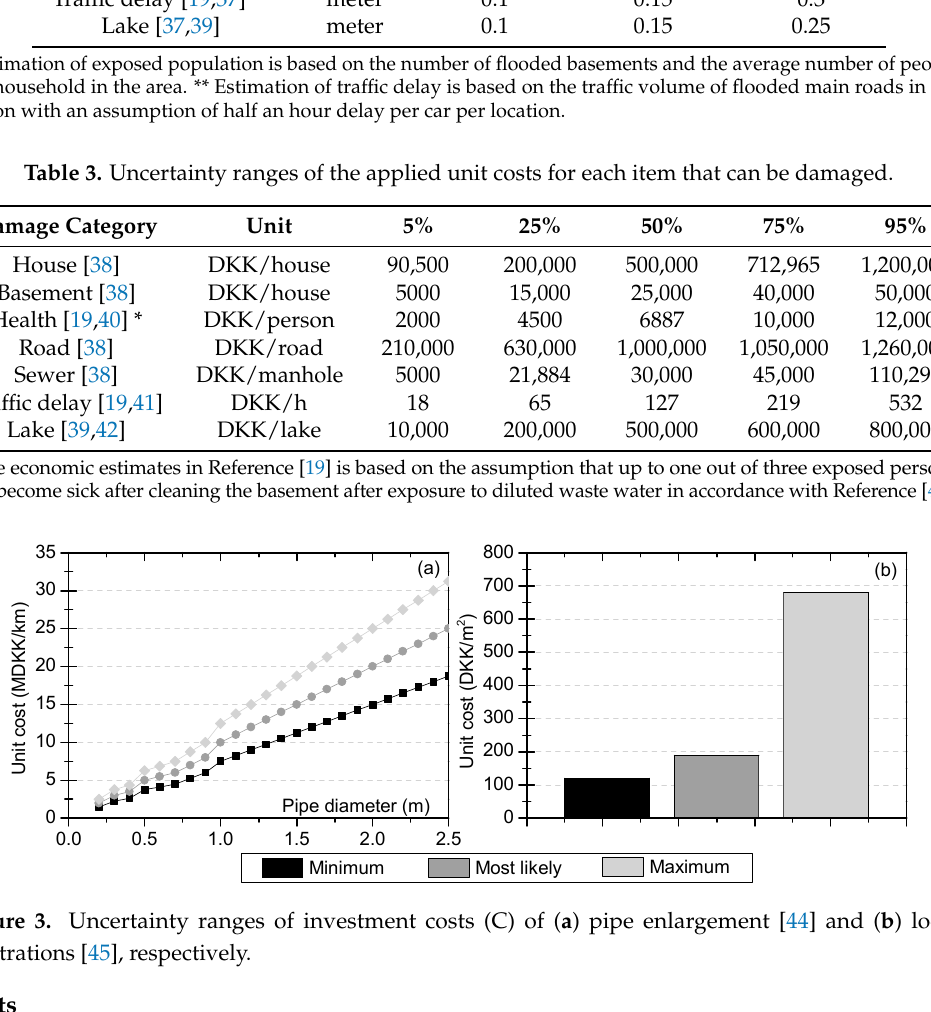
Table 1. Uncertainty ranges for climate factors for the different return periods, all for a planning horizon of 100 years.